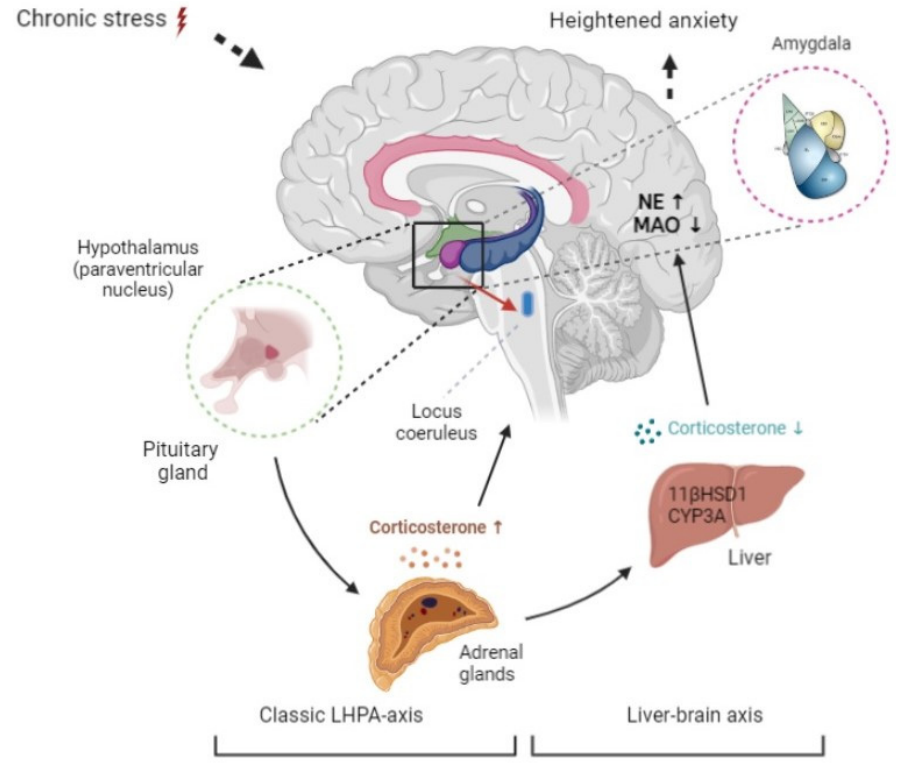
Figure 1. The proposed mechanism for developing anxiety-like behavior in the presence of reduced plasma corticosterone via the liver–brain axis. Initially, activation of the limbic-hypothalamic-pituitary-adrenal system increases corticosterone. This leads to activation of hepatic glucocorticoid-metabolizing enzymes, CYP3A, and 11- β HSD-1, and plasma corticosterone falls. This causes a decrease in brain MAO activity and an increase in brain norepinephrine. As a result, anxiety increases in spite of reduced plasma corticosterone.